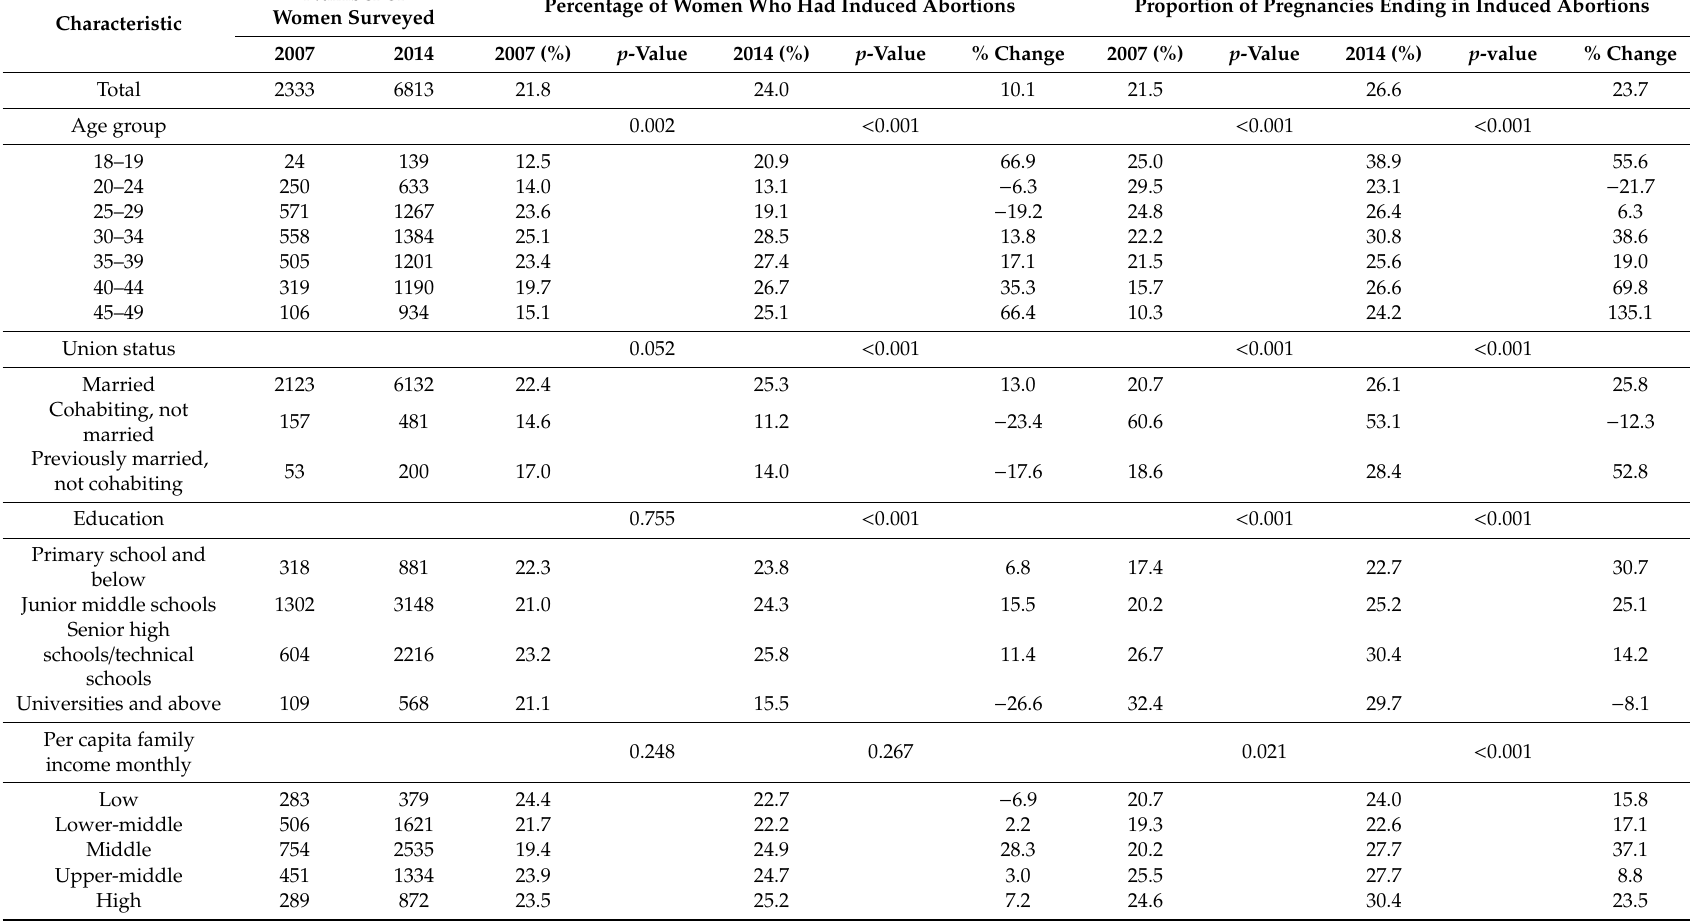
Table 1. The percentage of women who had induced abortions and the proportion of pregnancies ending in induced abortions between 2007 and 2014 among sexually active female migrants in major cities in